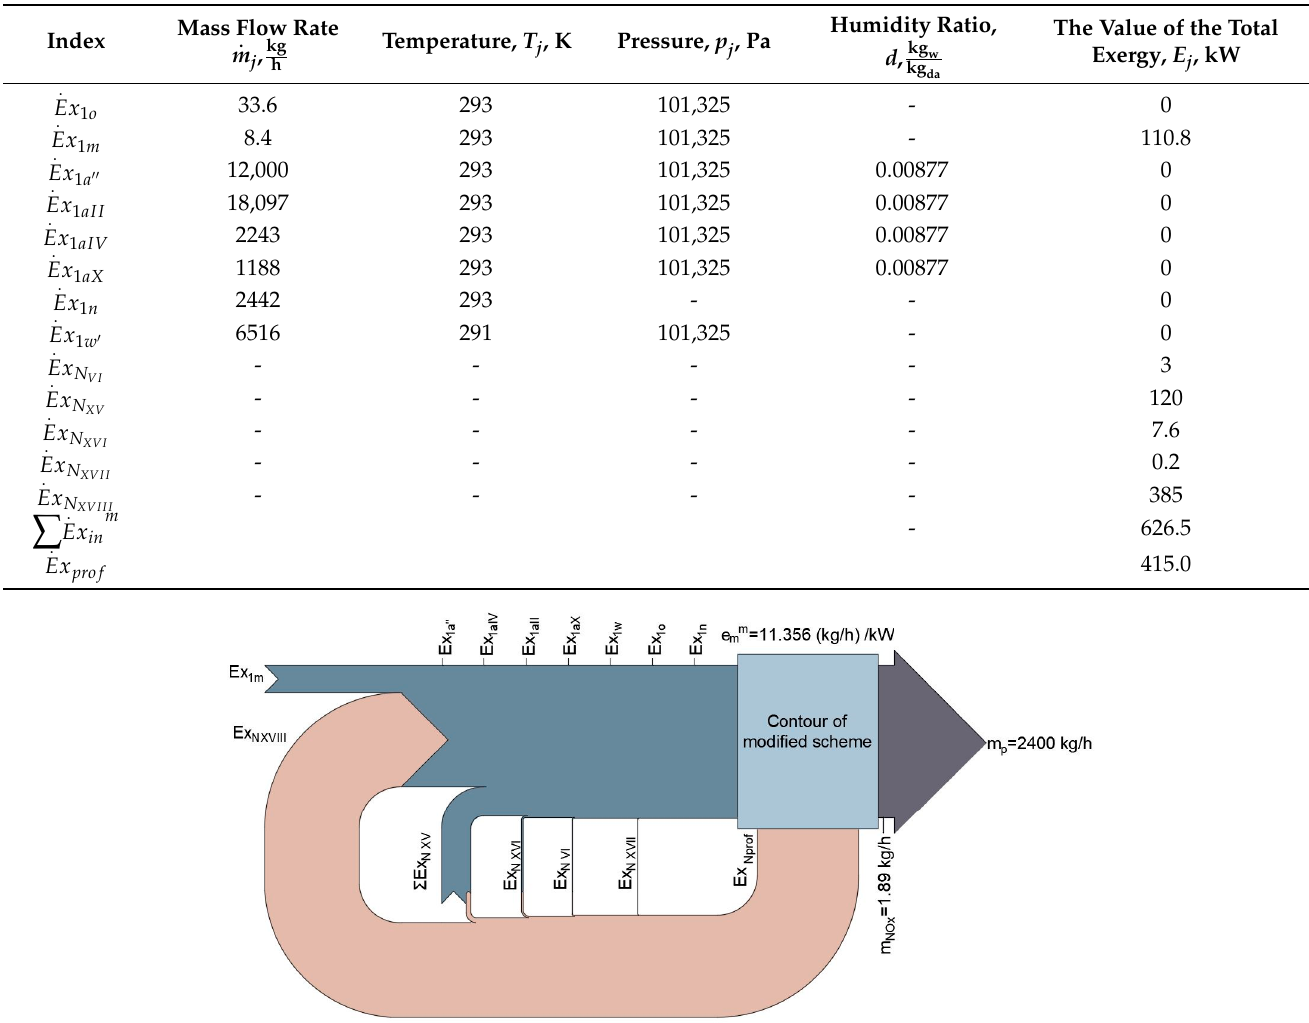
Table 2 comprises exergy values, included in (11). Figure 6 demonstrates the supplied exergy flows and production supplied flow via Sankey diagram. Table 2. The value of exergy crossing the contour of the modified scheme.